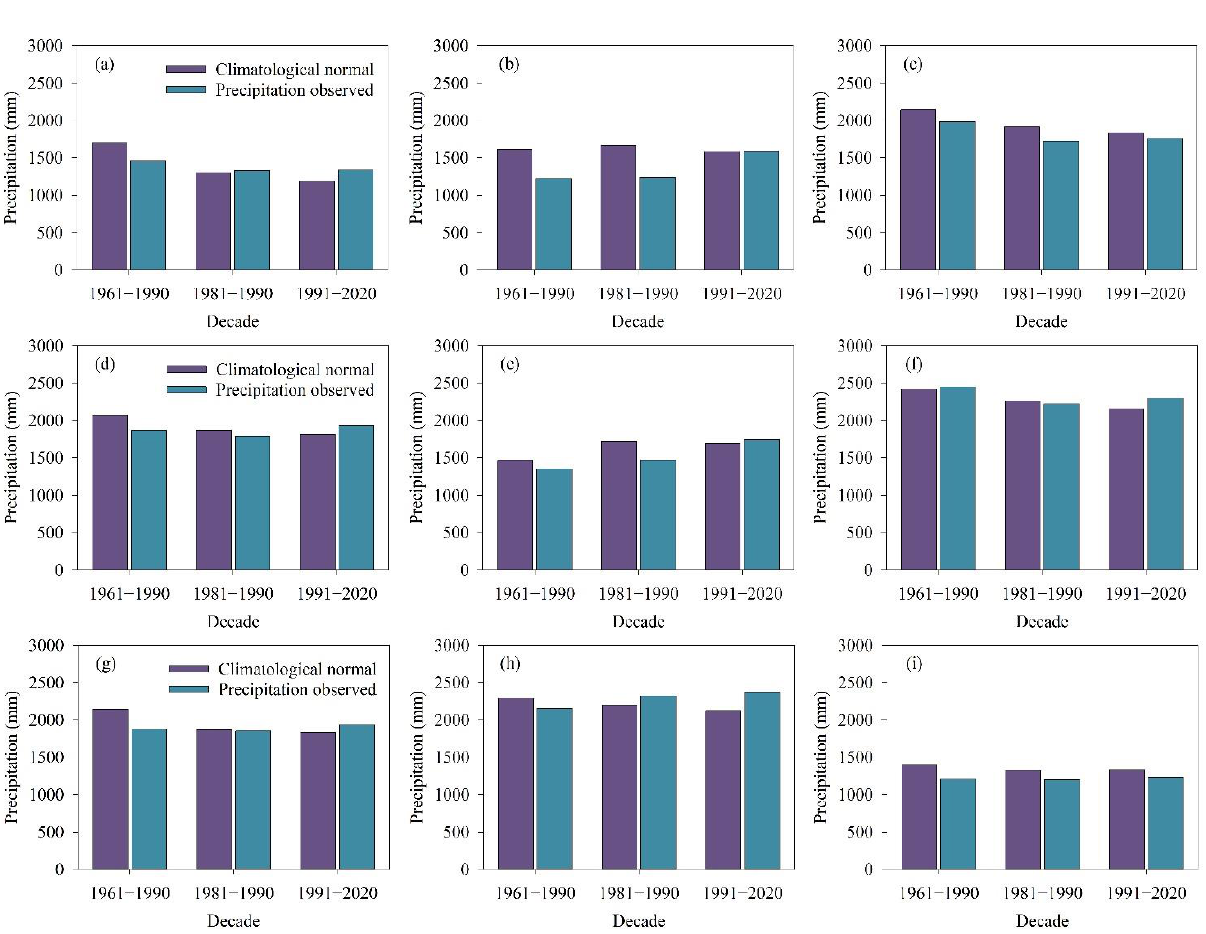
Figure 10. Comparison between observed rainfall and climatological normal in the capitals Aracaju ( a ), Fortaleza ( b ), João Pessoa ( c ), Maceió ( d ), Natal ( e ), Recife ( f ), Salvador ( g ), S ã o Lu í s ( h ), and Teresina ( i ).